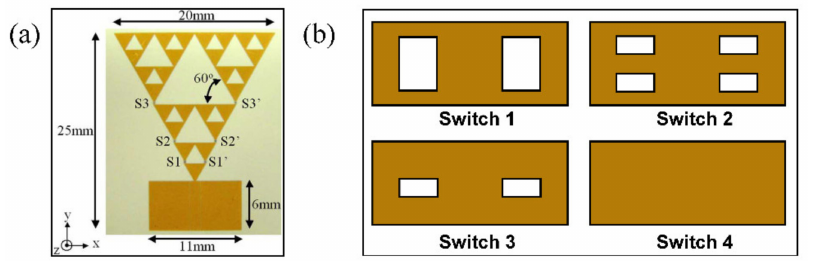
Figure 5. ( a ) Photograph of the fabricated reconfigurable antenna with MEMS switches [83] Reprinted/adapted with permission from Ref. [83]. 2007, IEEE. ( b ) Varieties of fabricated MEMS beams. Nickolas et al. [80] proposed an RF MEMS-integrated phased antenna based on a flexible organic substrate. The integrated phased antenna system is mainly composed of a patch antenna array, RF power distribution network, phase shifter and low noise amplifier (LNA). Patch antennas are used to receive radiation signals. LNAs provide signal amplifi- cation function. RF MEMS phase shifters based on LCP control the phase of microwave signals. When the LCP substrate thickness is 100 µ m, the loss on the transmission line is 0.375 dB/cm. The total length of the feedback network is 10.04 cm and the total loss